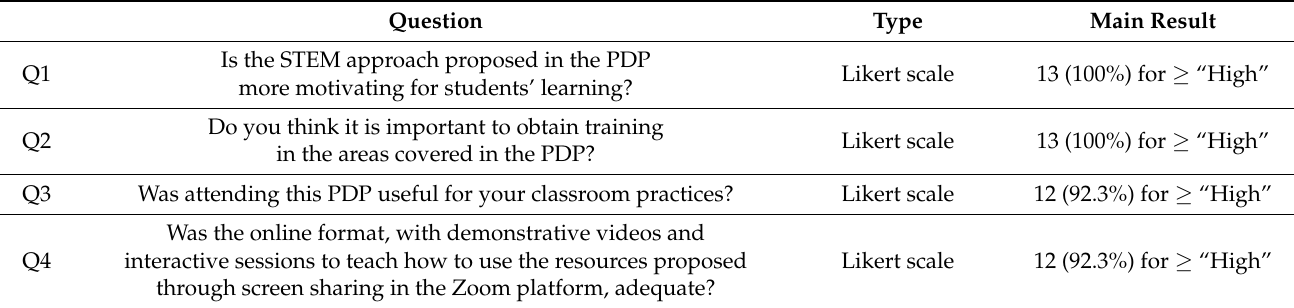
Table 4. Questions of the questionnaire.